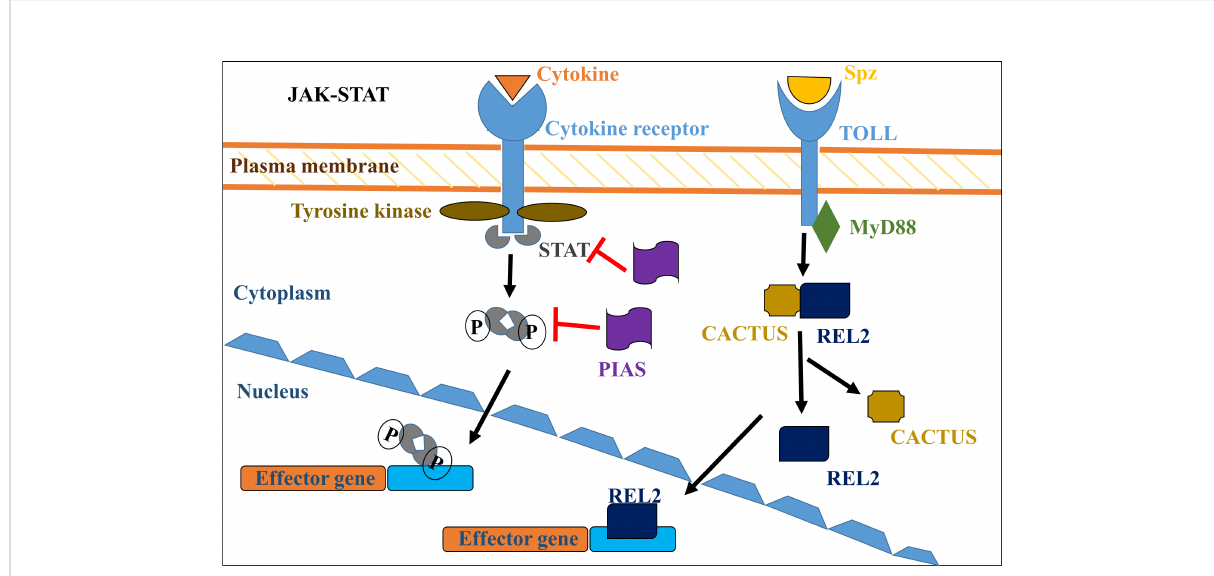
FIGURE 1 JAK-STAT and Toll-signaling pathway responsible for the activation of the immune system in mosquitoes. Activation of the signaling pathway initiates the formation of a multiprotein complex consisting of protein kinases, transcription factors, and the regulatory molecules to control the downstream genes that initiate and stimulate the immune